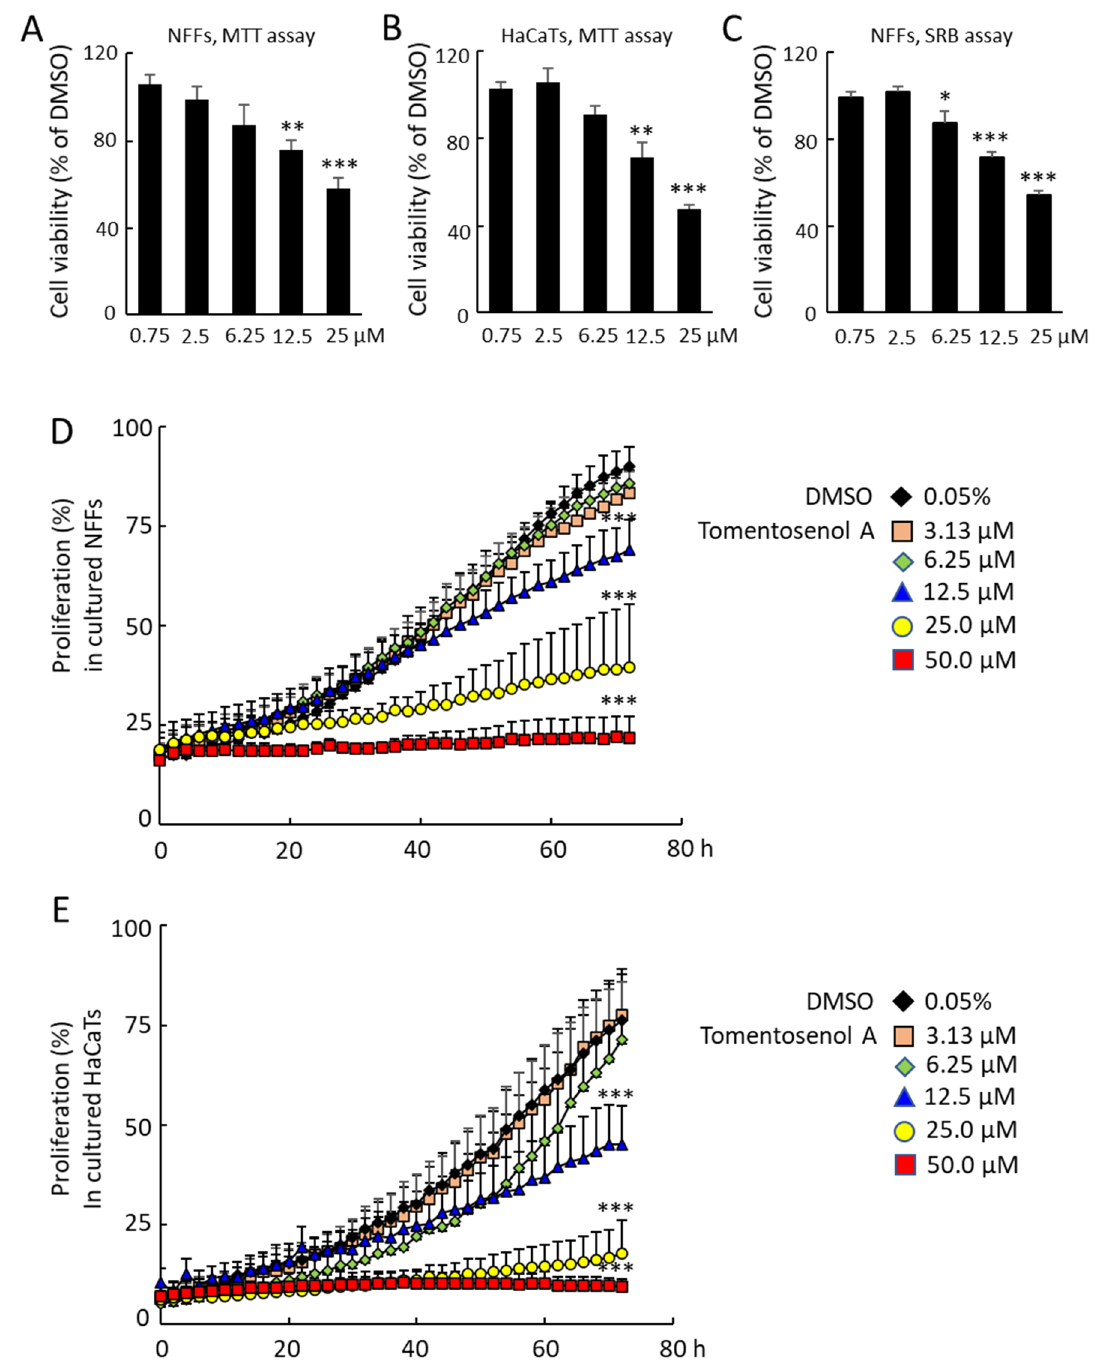
Figure 4. Effects of Compound 1 on neonatal human foreskin fibroblast (NFF) and immortalised keratinocyte (HaCaT) cell viability (( A , B ), MTT assay; ( C ), sulforhodamine B assay), and proliferation. The NFF ( A , C ), and HaCaT cells ( B ) were incubated with Compound 1 for 24 h. Cell viability was determined following 4 h incubation with MTT (3-(4,5-dimethylthiazol-2-yl)-2,5-diphenyltetrazolium bromide), or 20 min incubation with sulforhodamine B. Suppression of NFF ( D ), and HaCaT cell ( E ) proliferation during 72-h treatment with Compound 1 . Data are mean ± SEM for n = 8 ( A – C ) or n = 3 ( D , E ) independent experiments. * p < 0.05, **, p < 0.01, ***, p < 0.001. Data were analysed using a Student’s t -test ( A – C ) or two-way ANOVA with repeated measures ( D , E ). Scratch wound assays were used to examine the effect of Compound 1 on NFF and HaCaT cell migration into a wound region. Compound 1 caused a concentration-